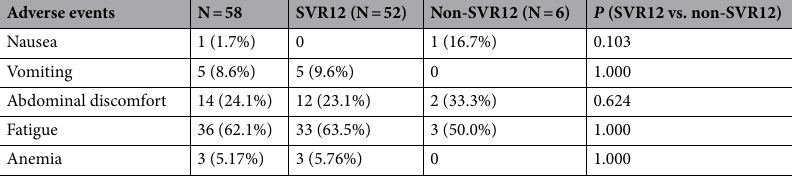
Table 3. Adverse events in study subjects (grouped by